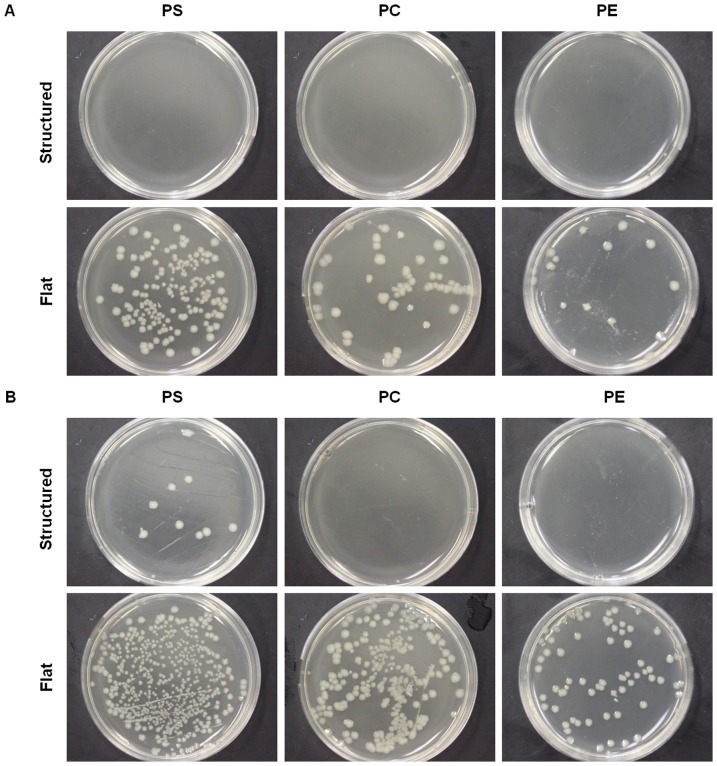
PS, PC, and PE structured and flat substrates were contaminated with a bacteria solution and either rinsed or not rinsed.The resulting bacterial growth can be observed in each plate in the form of colonies following 24 hour incubation. (A) Substrates were rinsed with 50 µL of PBS after bacteria solution was deposited on the surface. (B) Substrates were not rinsed.